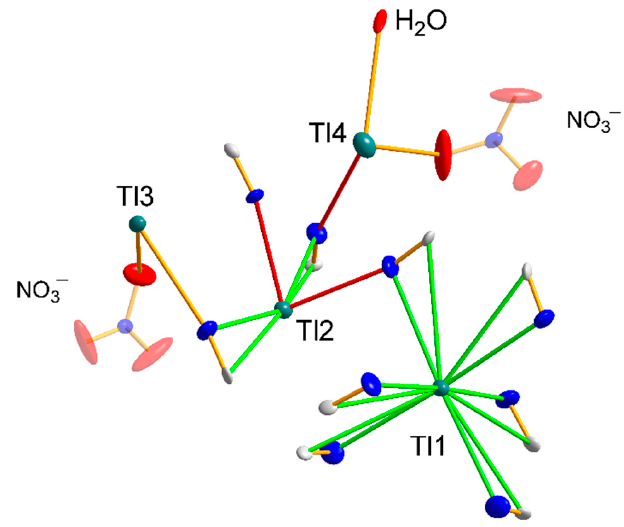
Figure 7. Coordination environment of the four thallium cations in structure 3 and their different bridging modes by cyanido ligands. “Side-on” bridging interactions are shown in green, and “end-on” interactions in red. All atoms shown are represented on thermal ellipsoids with a probability of 30%.